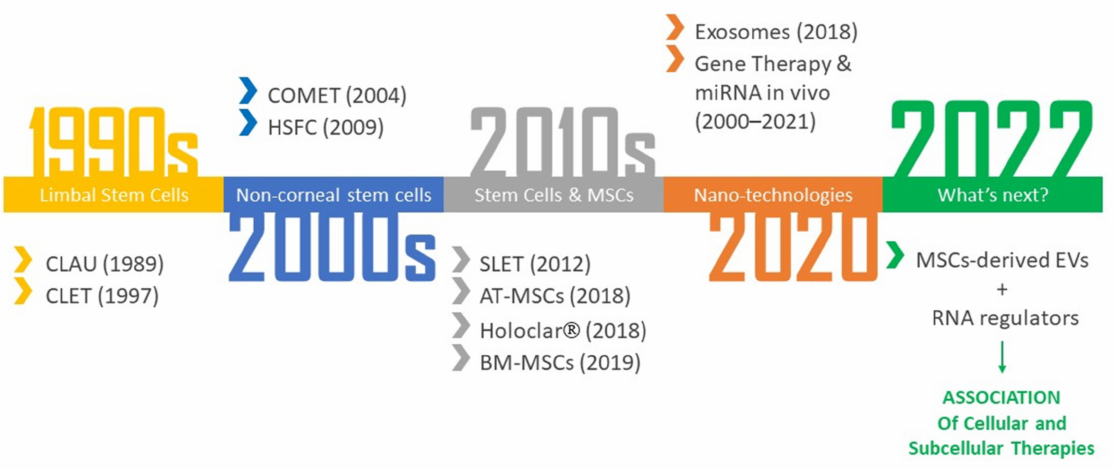
Figure 5. Historical development of corneal regeneration. This diagram summarizes the different steps and goals of corneal regeneration over the years. CLAU: Conjunctival–limbal autograft; CLET: ex vivo cultivated limbal epithelial transplantation; COMET: autologous ex vivo cultivated oral mucosal epithelial cells; HFSCs: hair follicle stem cells; SLET: simple limbal epithelial transplantation; AT-MSCs: adipose-tissue-derived mesenchymal stem cells; Holoclar ® , ex vivo expanded autologous human corneal epithelial cells containing stem cells; BM-MSCs: bone marrow-derived mesenchymal stem cells; EVs, extracellular vesicles; siRNA, silent interfering RNA, miRNA,